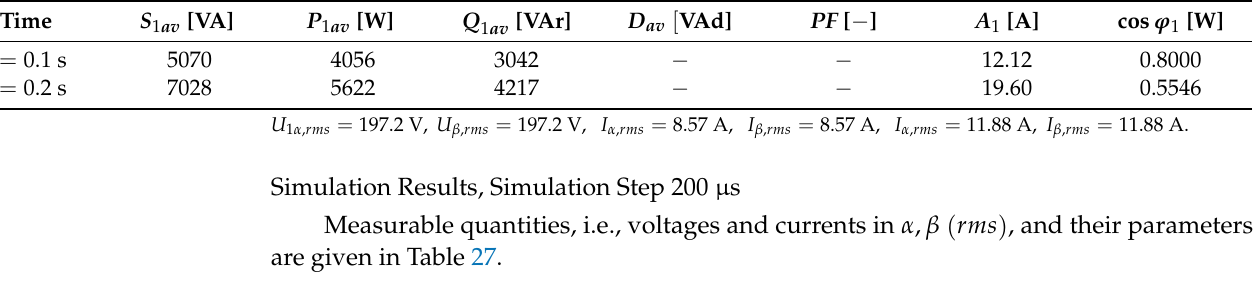
Table 27. Simulation results before and after the change (at steady states).